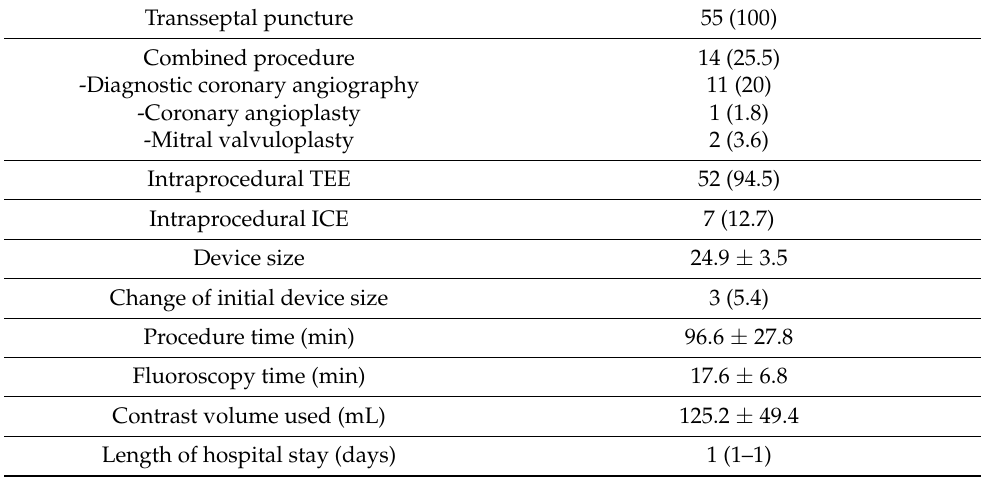
Table 2. Procedural characteristics ( n = 55).